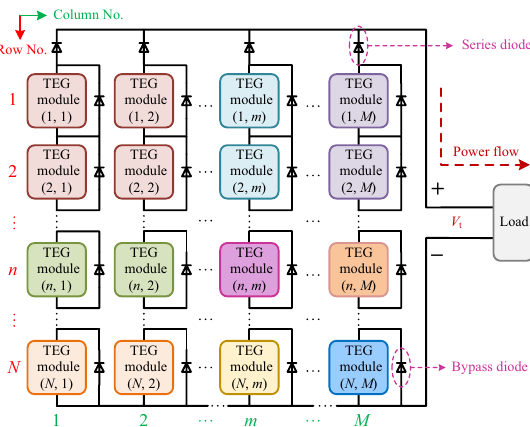
Fig. 2 Configuration of ( N